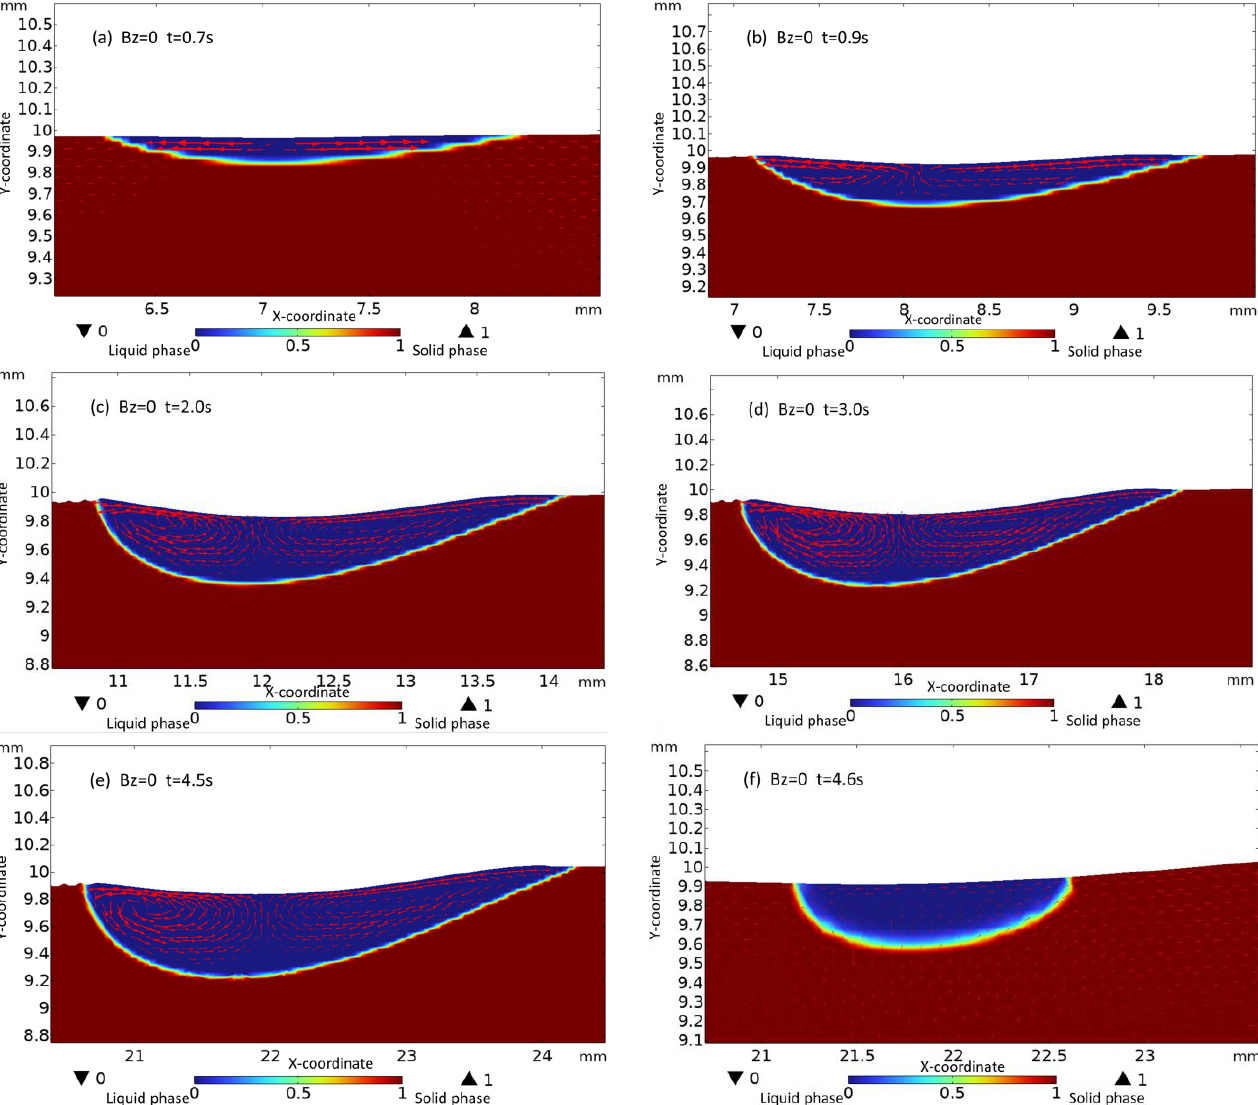
Figure 9. Evolution of laser remelting pool. ( a ) t = 0.7 s; ( b ) t = 0.9 s; ( c ) t = 2 s; ( d ) t = 3 s ( e ) t = 4.5 s; and ( f ) t = 4.6 s.